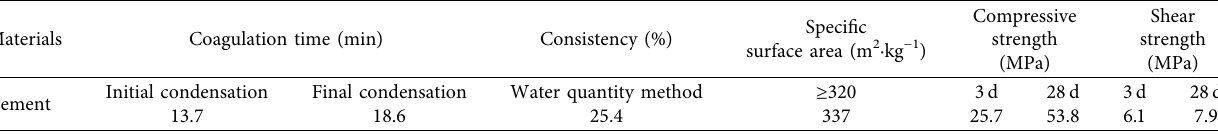
Table 2: Main physical property indexes of PO. 42.5 composite silicate